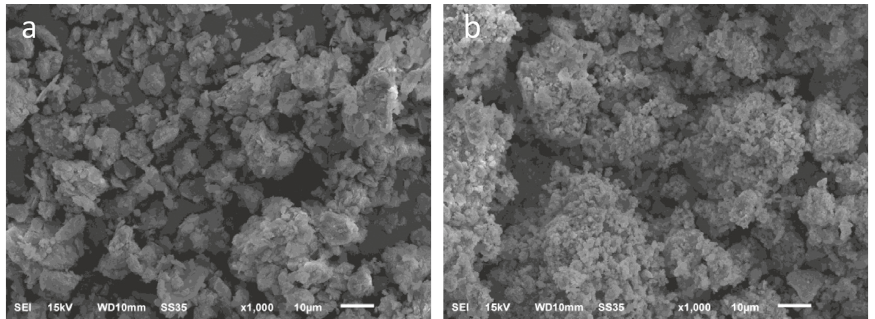
Figure 2: Scanning electron microscope image of (a) raw material 1000 × and (b) ceramsites 1000 ×